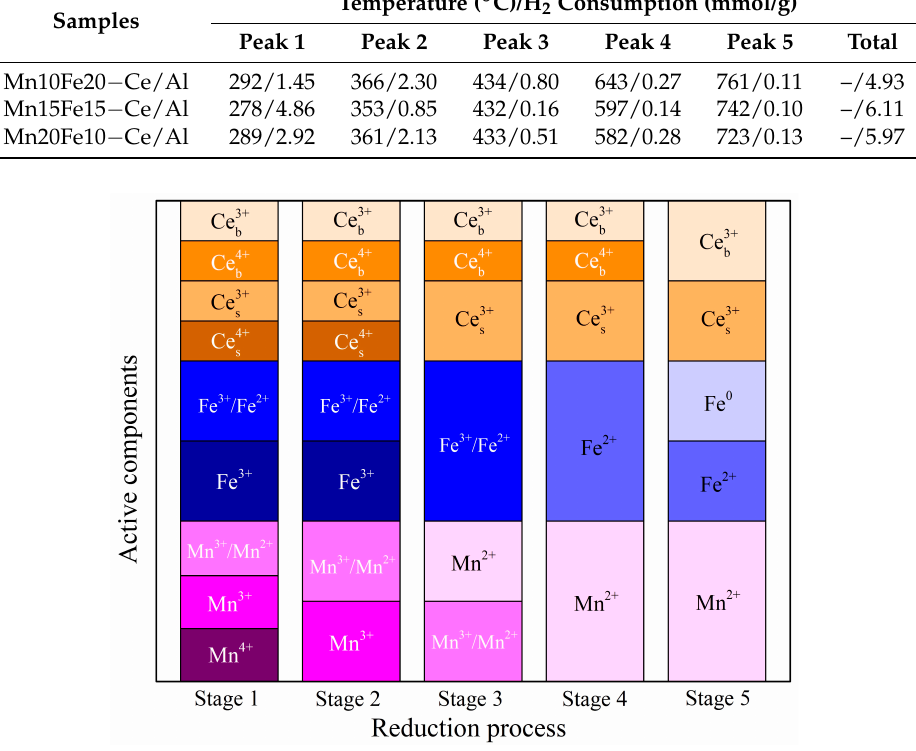
Figure 5. Graphical representation of the reduction process of Mn − Fe − Ce − O x / γ‐ Al 2 O 3 nanocatalysts with the reduction agent of H 2 from 100 to 900 °C.